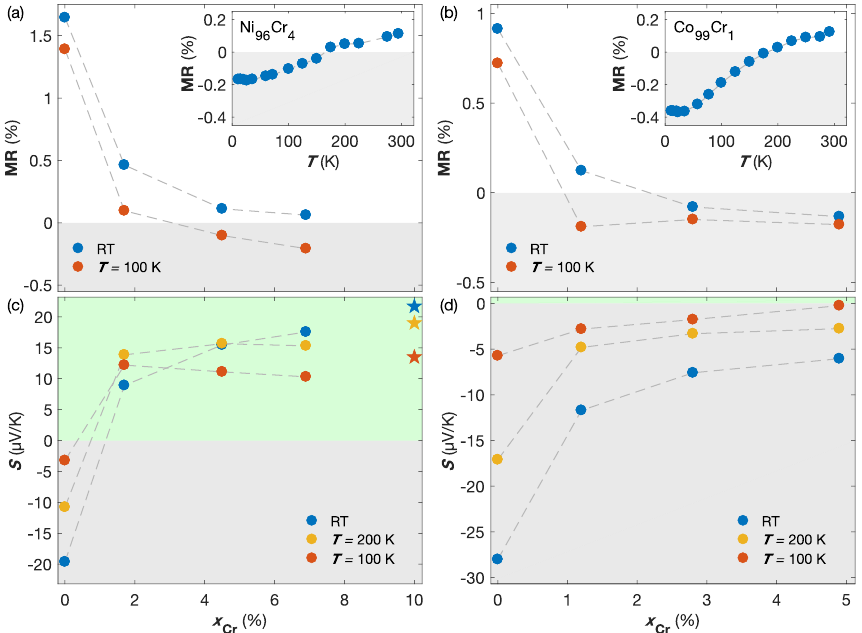
Figure 15. ( a ) anisotropic magnetoresistance and Seebeck coefficient of NiCr and CoCr CNW vs. Cr content at different temperatures. ( a , b ) MR ratio vs. the Cr content for NiCr ( a ) and CoCr ( b ) samples at RT (blue) and T = 100 K (red). The insets in ( a ) and ( b ) show the MR ratio of the Ni 96 Cr 4 and Co 99 Cr 1 samples in function of temperature, respectively. The grey areas in ( a , b ) indicate negative AMR. ( c , d ) Seebeck coefficient vs. Cr content for NiCr ( c ) and CoCr ( d ) samples at RT (blue), T = 200 K (yellow) and T = 100 K (red) (from [66]). Figure adapted from ref. [66] with permission of the